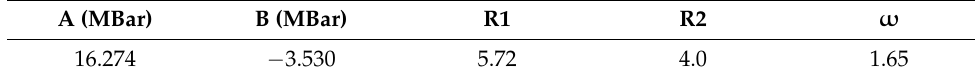
Figure 1. Hugoniot curve and fitted JWL curve. Table 3. Parameters of JWL equation of state of unreacted